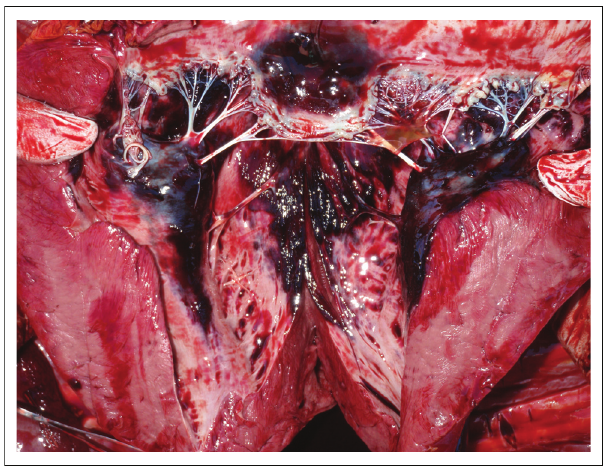
Source : Photo taken by R.G. Bengis FIGURE 4: Diffuse subendocardial ecchymoses in a zebra following cyanobacterial